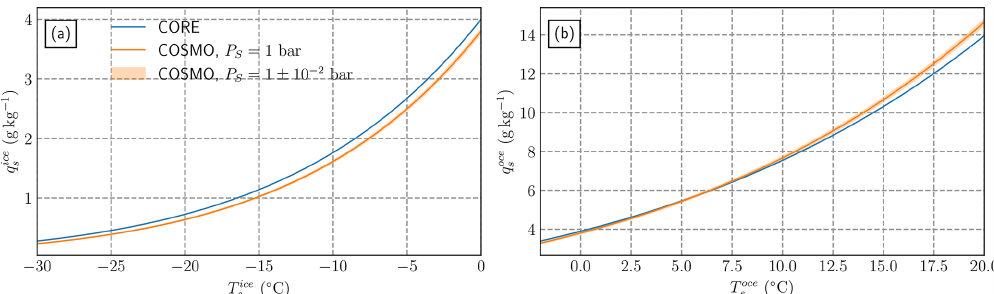
Figure E2. Comparison in surface moisture diagnostics (i.e., T s (cid:55)−→ Q s (T s ) ) over (a) sea ice and (b) open ocean for the COSMO and the CORE (Large and Yeager, 2004)